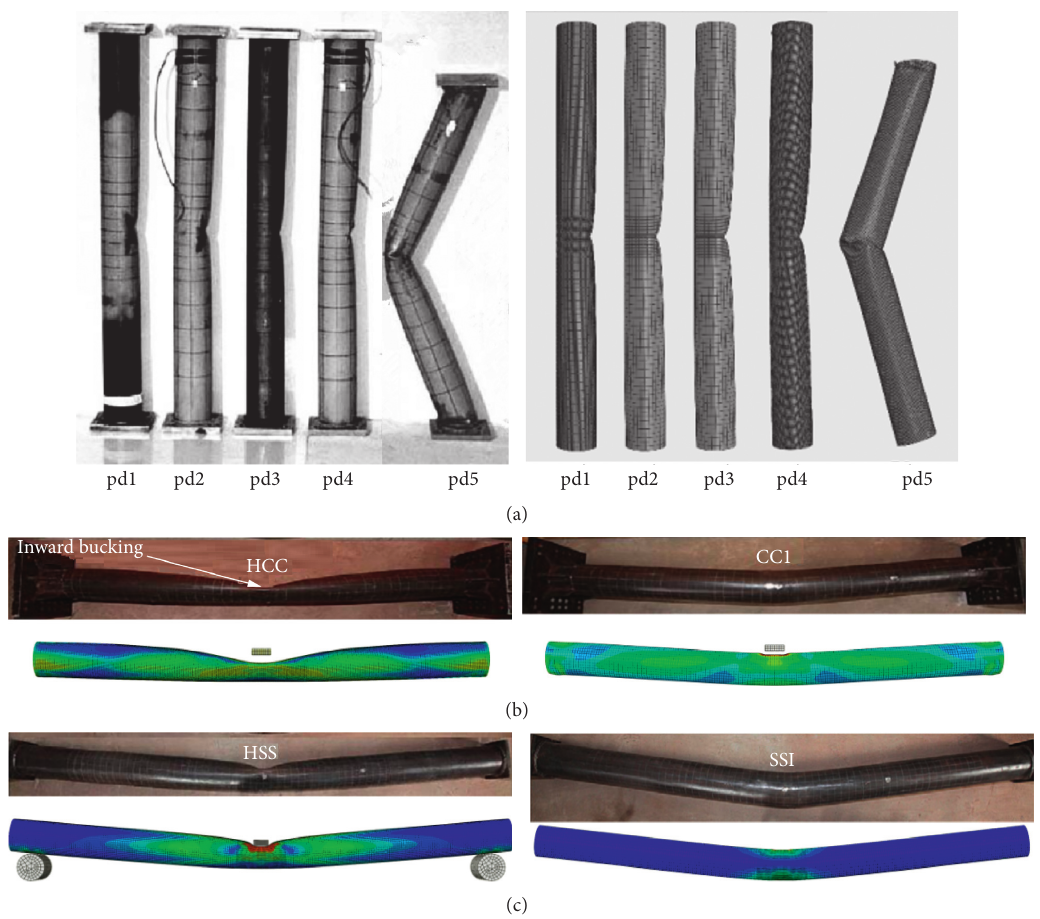
Figure 1: Failure mode comparison tests and FEA. (a) Failure tests from [22]. (b) Failure tests from reference [23]. (c) Failure tests from [24].